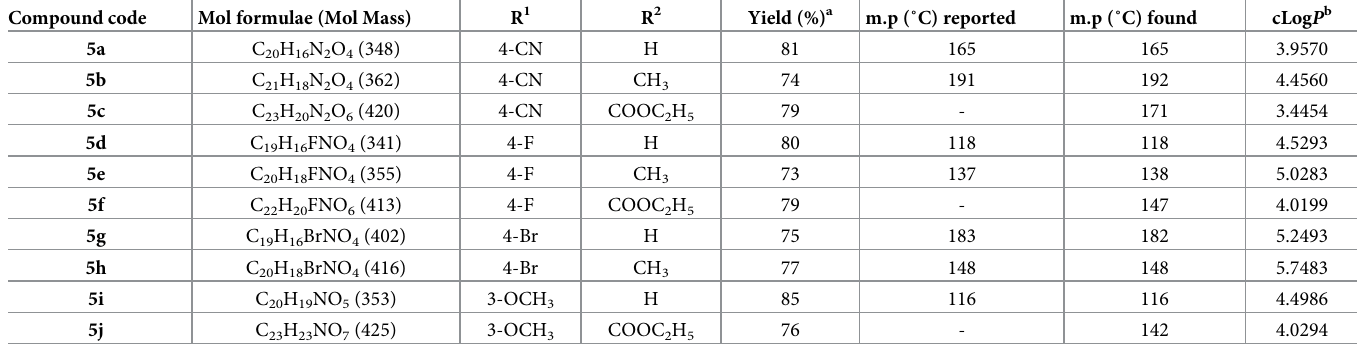
Table 1. Physicochemical parameters of ethyl 7-methoxy-3-(substituted benzoyl)-indolizine-1-carboxylate 5a–5j. Compound